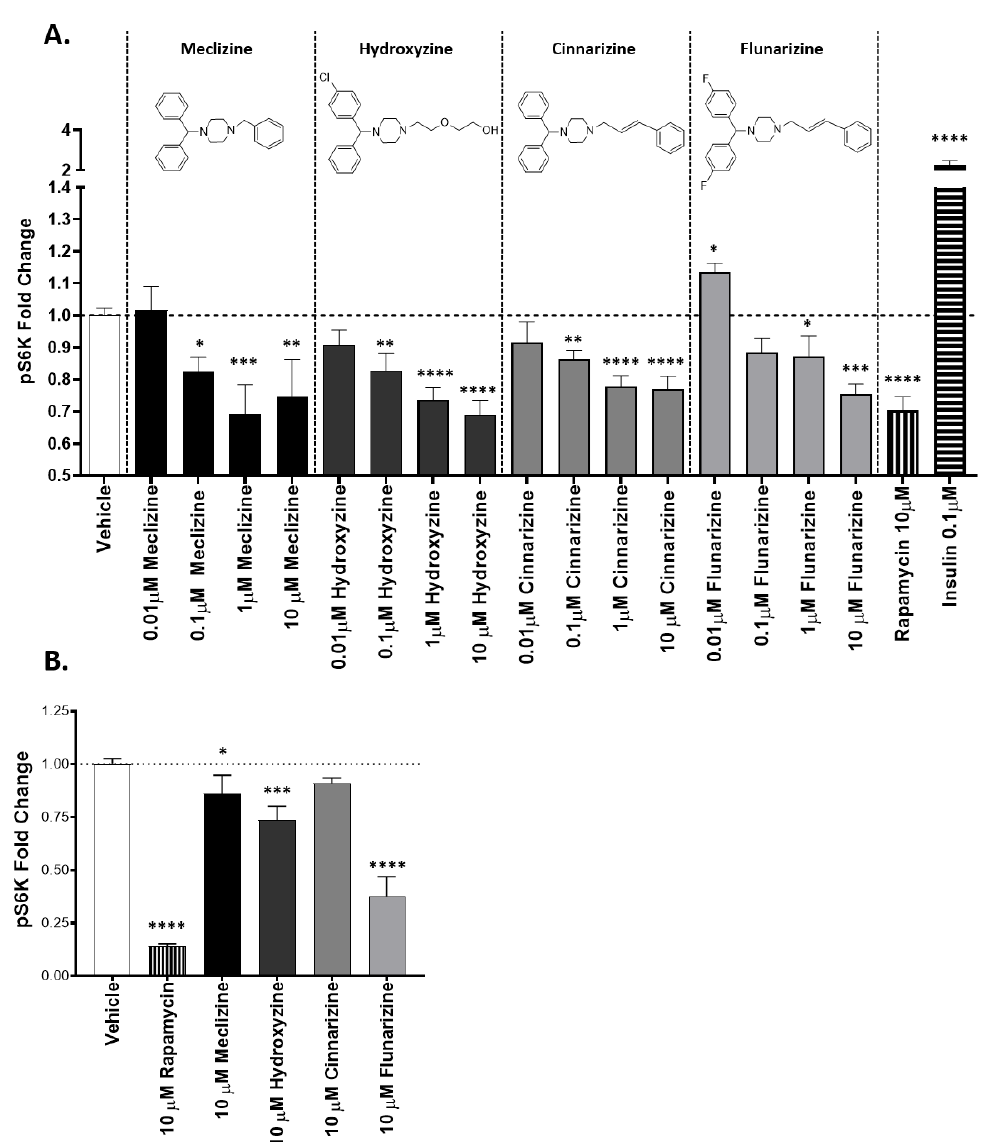
Figure 1. Confirmation of mTORC1 inhibition by piperazine compounds. ( A ) Piperazine drugs dose-dependently inhibit mTORC1 downstream target S6Kinase in mouse FL83B cells. ( B ) Piperazine drugs inhibit GBM stem cells at a single concentration of 10 µM. The amount of phosphorylated S6Kinase relative to total S6Kinase was measured by ELISA. The bars are the fold change over the vehicle control. Error bars are 1 standard deviation. Data shown for meclizine, hydroxyzine, cinnarizine, and flunarizine as indicated. *, **, ***, **** correspond to p values less than 0.05, 0.001, 0.0001, and 0.00001 respectively. n = 3 for each group. p value calculated with Student’s t-test.